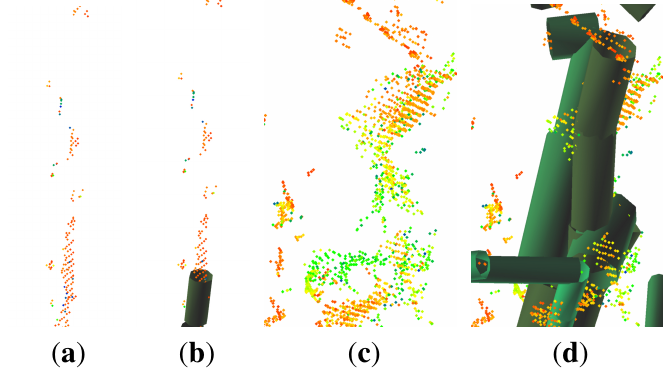
Figure 13. Close up view of P. massoniana (P#10, height ≈ 16.4m): (a) a sub point cloud containing low amount of information of twig; (b) the cylinder model of the twig ends in an occlusion gap; (c) a sub point cloud still retaining a large number of noise points; (d) overestimated cylinders representing